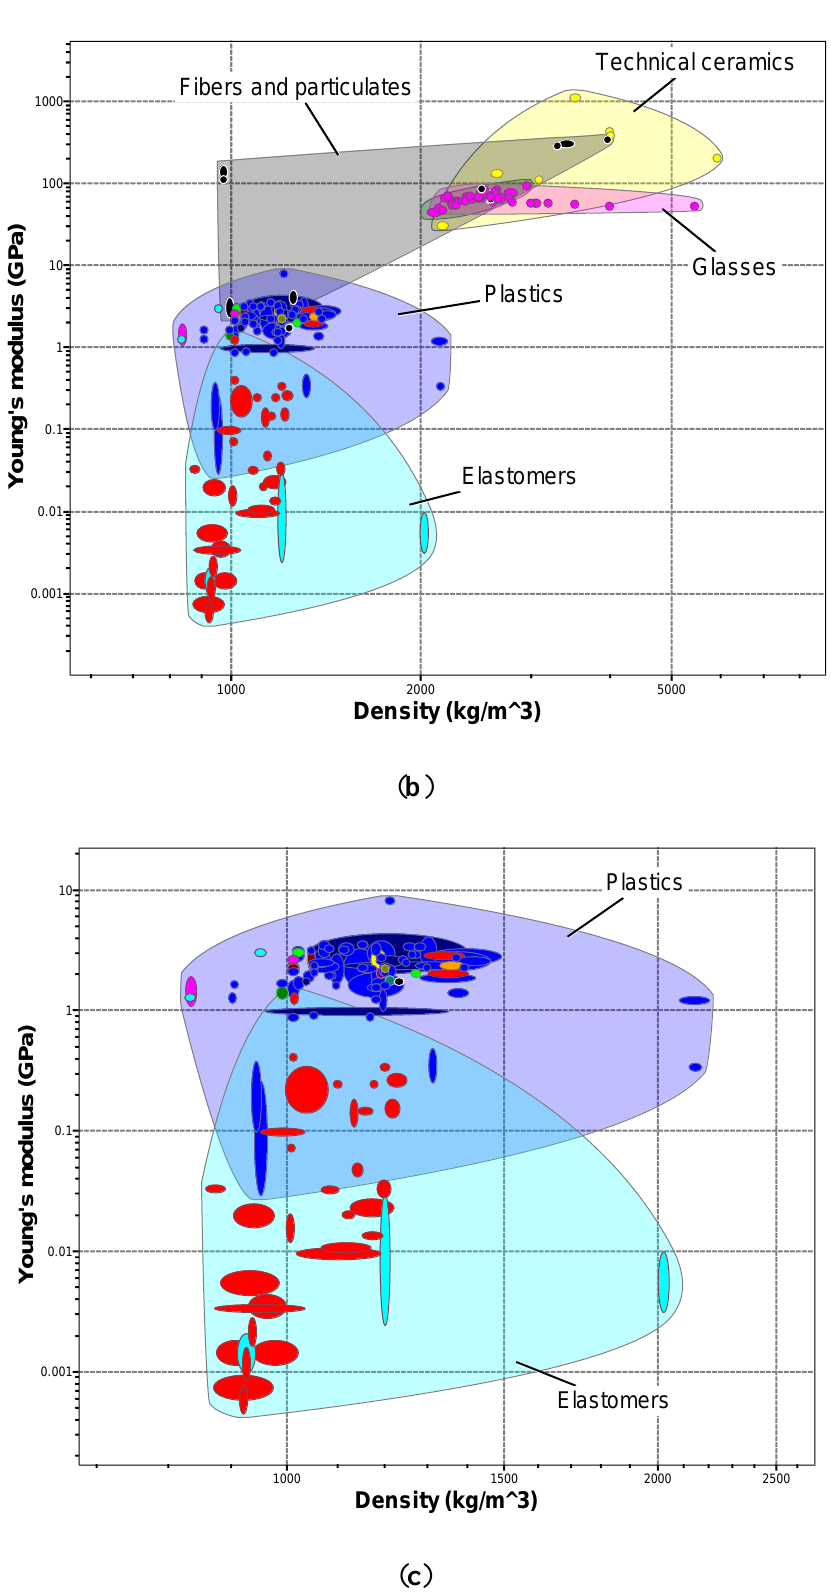
Figure 2. Materials selection for transparent medical face masks. Screening stage: (a) the list of candidate materials passed “transparency” filter; (b) Ashby charts for all transparent materials; (c) for polymers and elastomers (Charts and data from CES EduPack 2019, Granta Design Limited, Cambridge, UK, 2019 [15]).